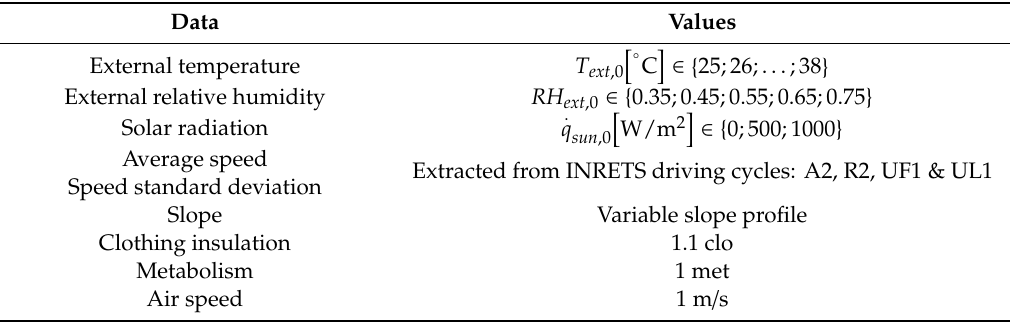
Table 3. Summary of test case data.